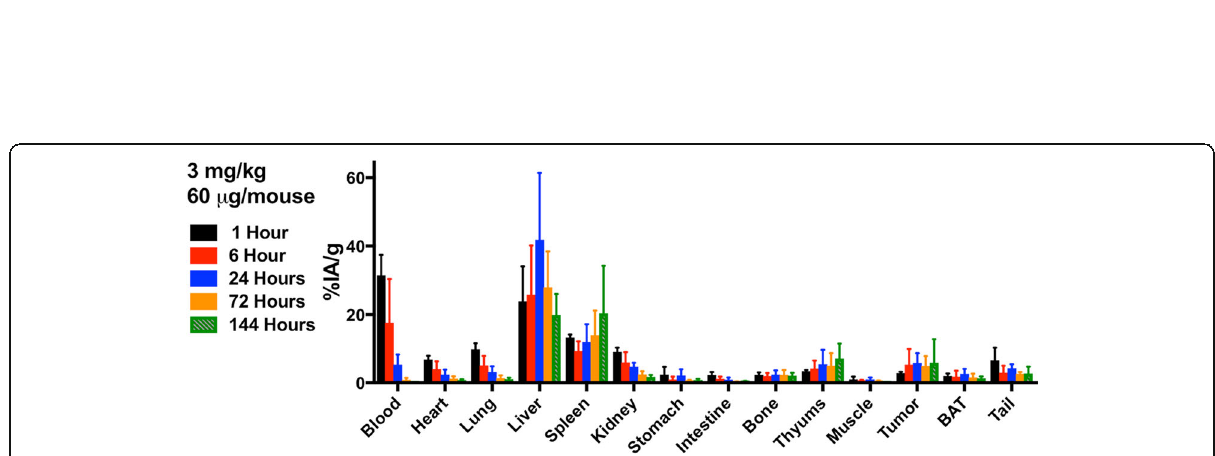
Fig. 5 Biodistribution of 225 Ac-DOTA-anti-PD-L1-BC (15 kBq) at 1, 6, 24, 72, and 144 h in neu -N mice bearing NT2.5 tumors. 225 Ac-DOTA-anti-PD-L1-BC was administered at the 3 mg/kg dose (60 μ